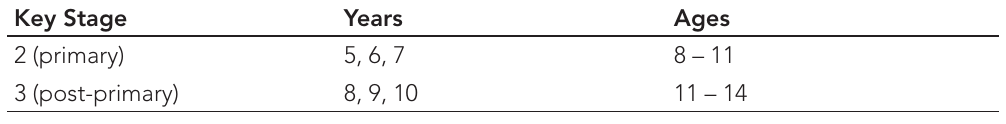
Table 1: Years and ages for compulsory education (Northern Ireland) at Key Stages 2 and